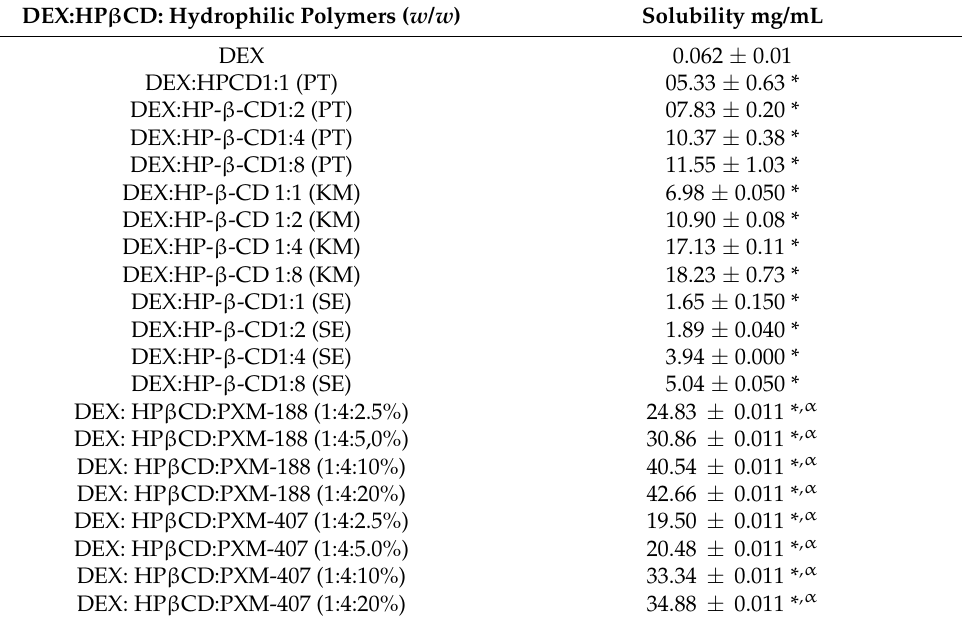
Table 3. Solubility data of DEX and binary and ternary inclusion complexes. Mean ± SD, n =